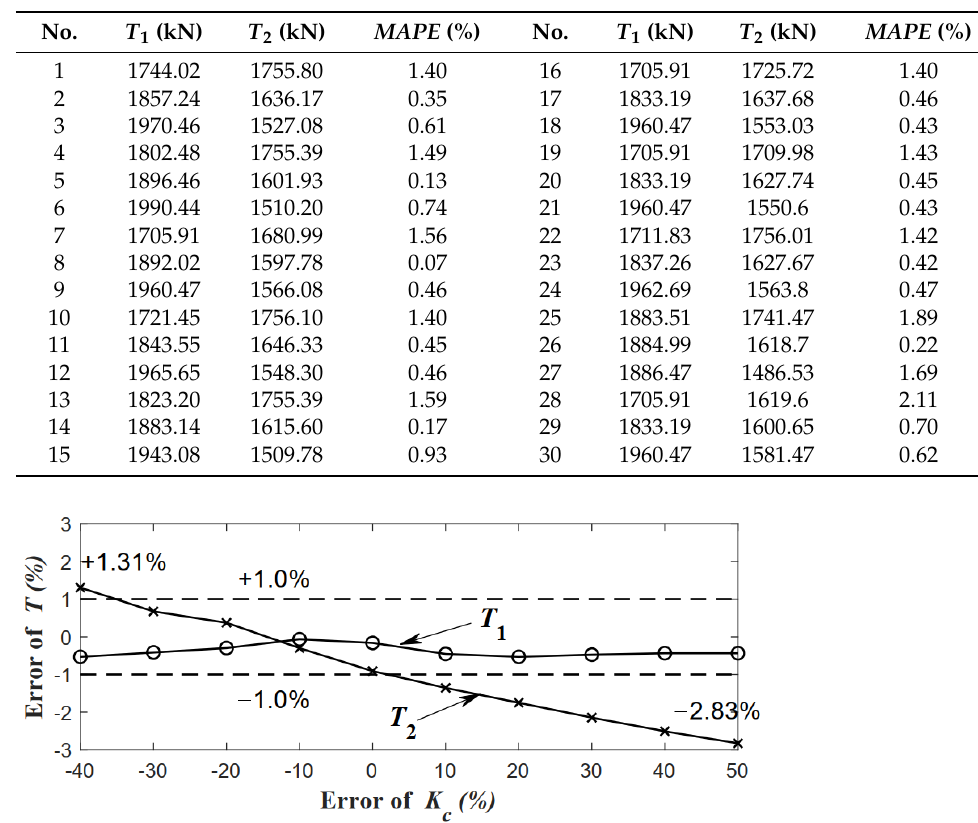
Figure 11. Relationship between the relative error of K c and relative errors of T 1 and T 2